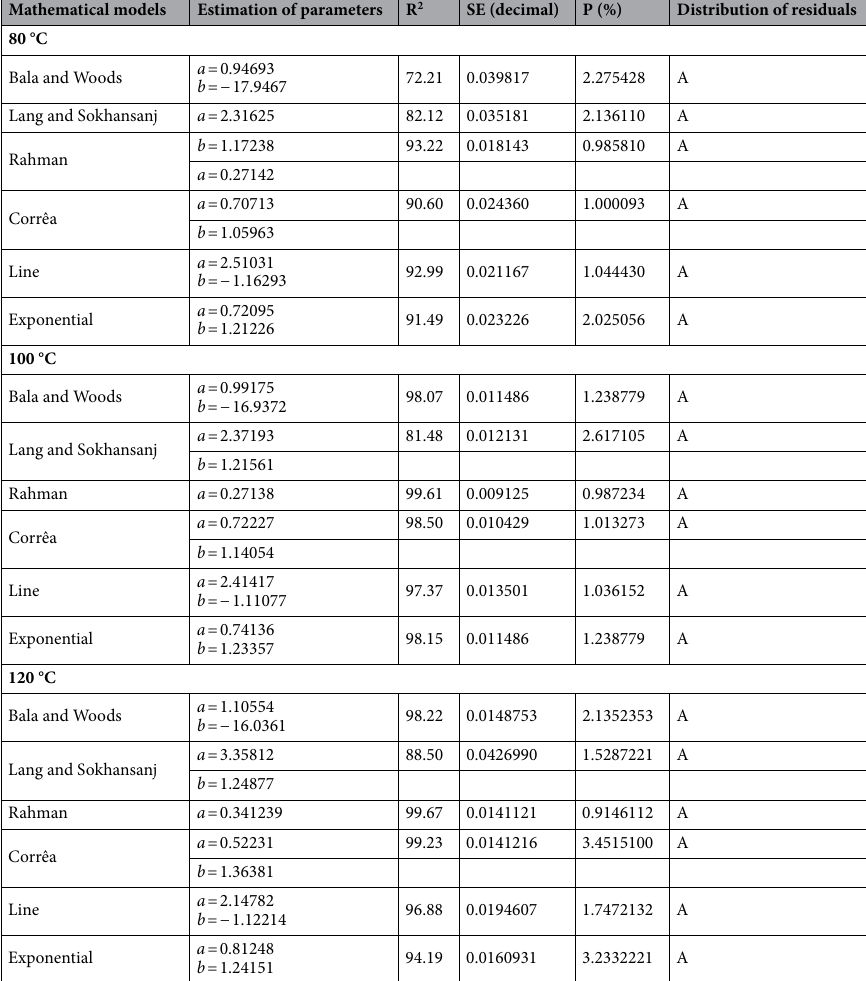
Ziegler et al 52 evaluated the effects of moisture content (12 and 15%) and storage temperature (11, 18, 25, and 32 °C) of soybeans on the functional properties of the protein isolate. Protein solubility reduced 18% with increasing temperature from 11 to 32 °C in soybean stored with 12% moisture. When the soybeans were stored with 15% moisture, the protein solubility reduced by 16% with increasing temperature from 11 to 32 °C. Fur- thermore, when soybeans were stored at the same temperature, for example, 25 °C, increasing moisture from 12 to 15% reduced protein solubility by 4%. Multivariate analysis. Cluster analysis showed the existence of four homogeneous groups for the variables evaluated (Fig. 4). G1 group gathered the largest number of treatments and stood out for the higher average of electrical conductivity and lower averages of acid oil and crude protein. The treatments allocated in this group belong to the higher storage times (4 and 8 months). G2 group allocated most treatments with zero storage time, which had the higher averages of oil yield and crude protein and intermediate values of electrical conductivity